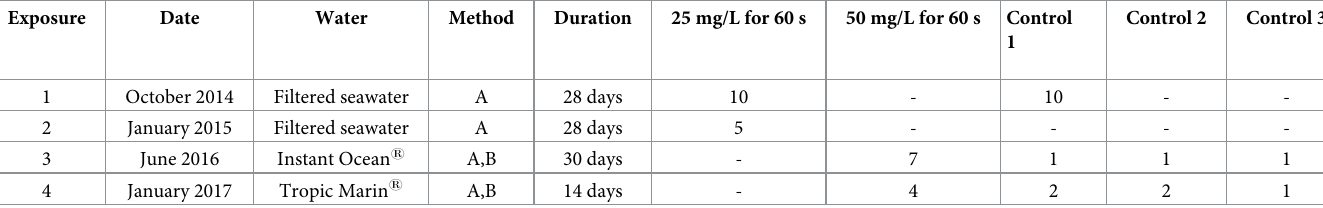
Table 1. Summary of cyanide exposure experiments at Roger Williams University. Numbers indicate the experimental units measured during each exposure. Control 1 indicates a negative control, a fish with no exposure. Control 2 is a positive control, and has a fish present with thiocyanate spiked to 20 μg/L daily with each water change. Control 3 has thiocyanate at 20 μg/L aerated with no fish present. Exposures 3 and 4 used two different brands of widely available synthetic seawater.